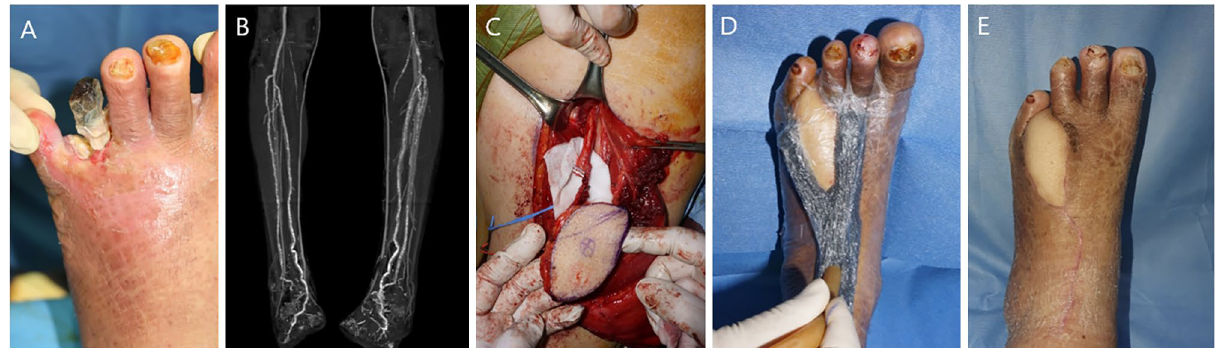
Figure 3. The first case of NPWT monitoring system in diabetic foot patient. ( A ) Photographic findings of 57-year-old male patient who was diagnosed with diabetic gangrene on left foot ( B ) CT angiography finding of lower extremities ( C ) Elevation of ALT free flap ( D ) NPWT was applied immediately after operation (E) Postoperative photographic finding; 3